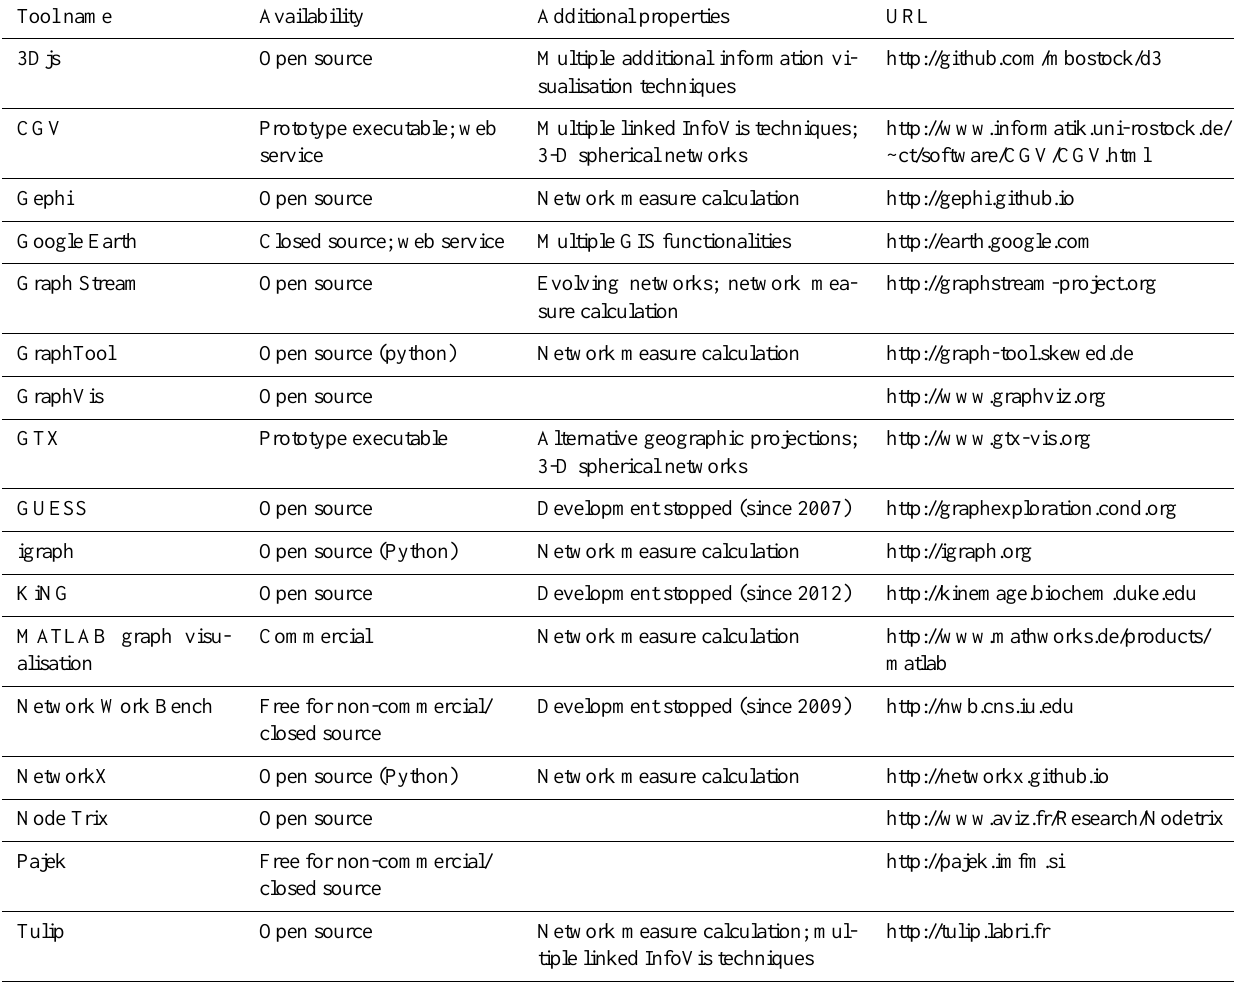
Table 1. Overview of existing tools applicable for climate network